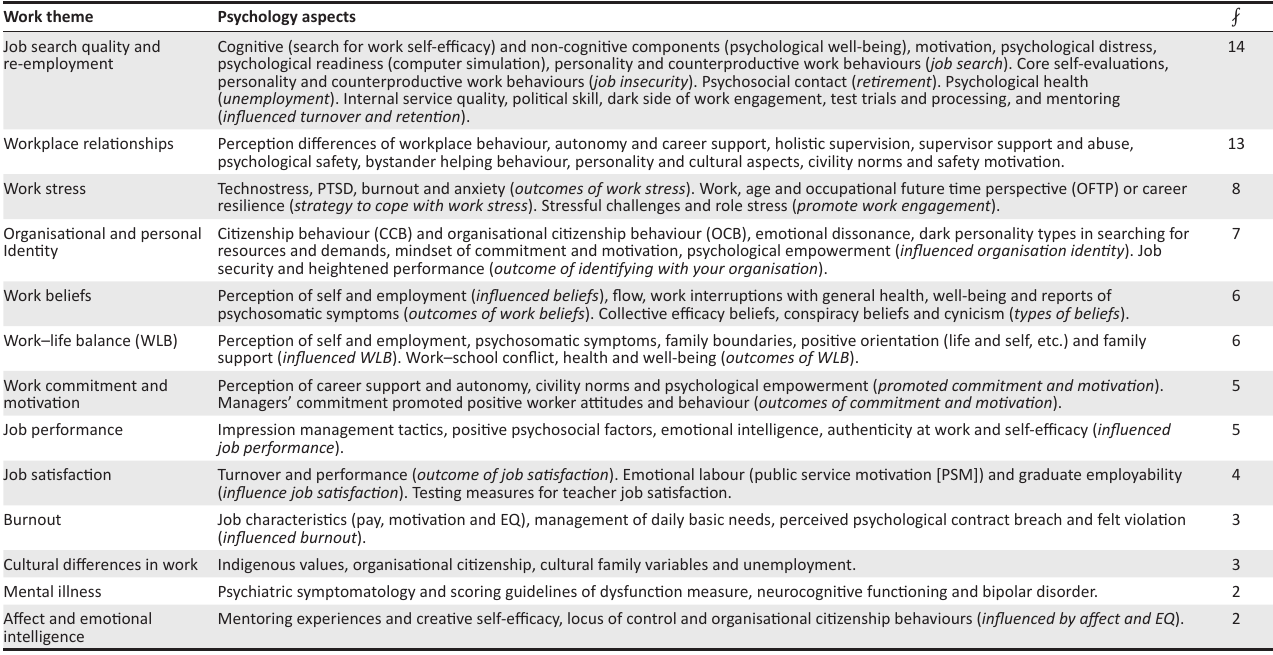
TABLE 7: Work-related themes and the psychology concepts as investigated by sampled